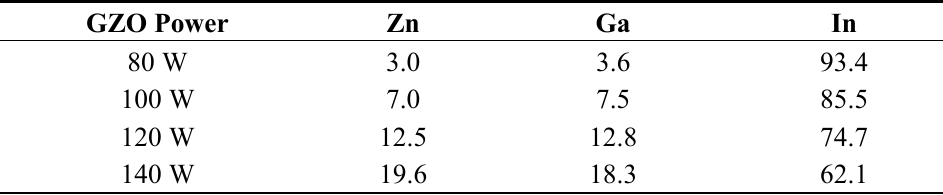
Table 1. Atom ratios of Zn, Ga as a function of deposition power of GZO